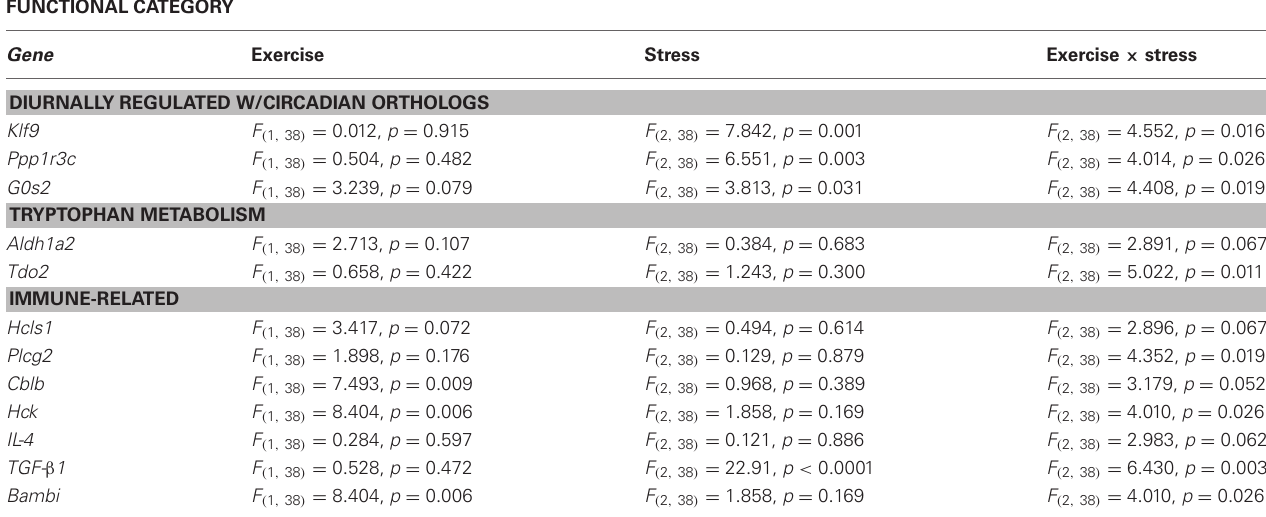
Table 4 | Effect of exercise on stress-induced alterations in the expression of select genes in the